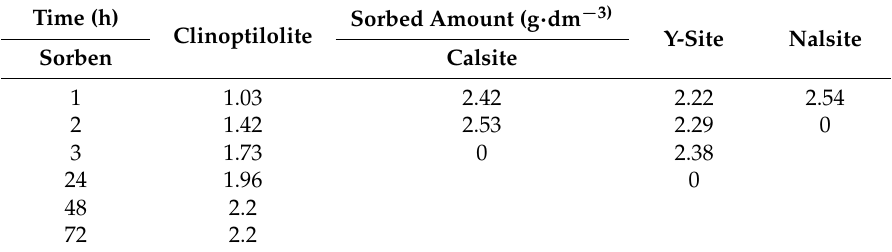
Table 4. The process of sorption in sorbents.